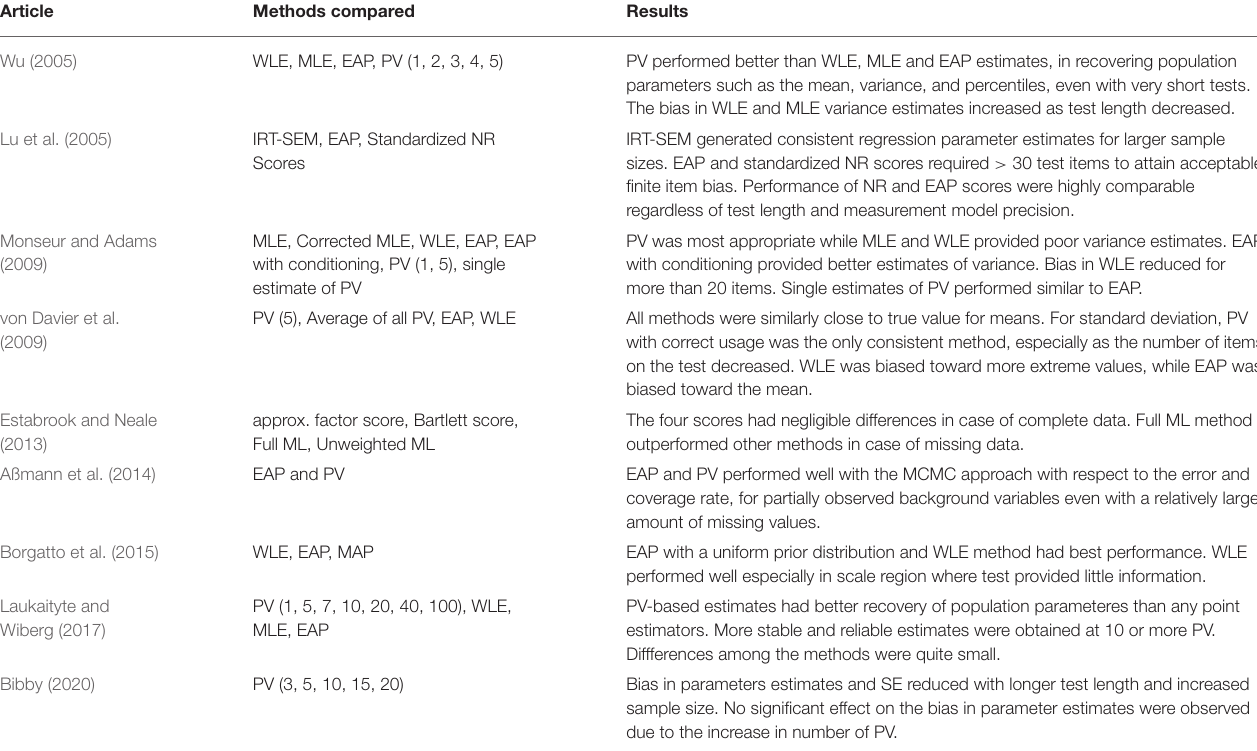
TABLE 3 | Results of simulation studies conducted by articles considered in Table 2